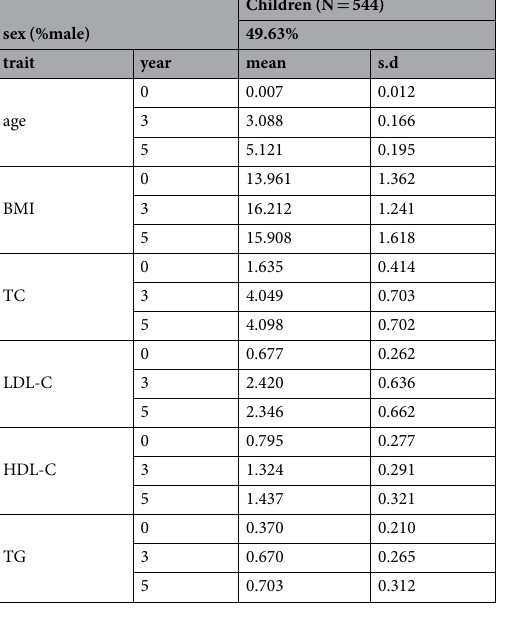
Table 1. Phenotypic information of subjects. BMI: Body mass index. S.D: standard